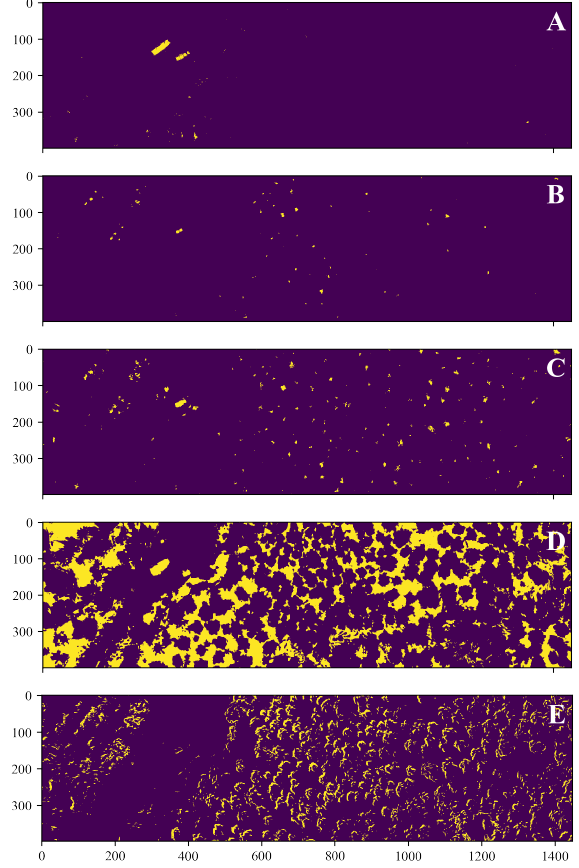
Figure 15. Anomaly detection maps of the MLM and reference methods for the forest dataset. A: MLM (cosine, variance, training set size 2500, R size 250), B: One-Class-SVM, C: Isolation forest, D: Global RX, E: Local